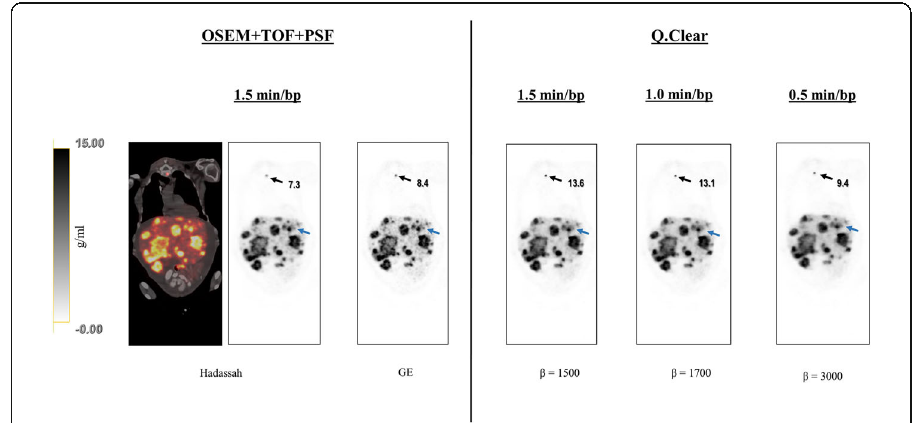
Phantom evaluation allowed us to determine that using the Q.Clear algorithm with β ≥ 1000 for 1.5 min/bp and β ≥ 1400 for 1.0 min/bp similar or improved BV and CNR values are obtained compared to Hadassah OSEM. However, the results showed that for 0.5 min/bp, improved CNR results are reached for β = 2200 for the large spheres but reduced by about 25% for the small volumes. This last observation can be related to the visualization assessment results obtained for 0.5 min/bp where the tumor